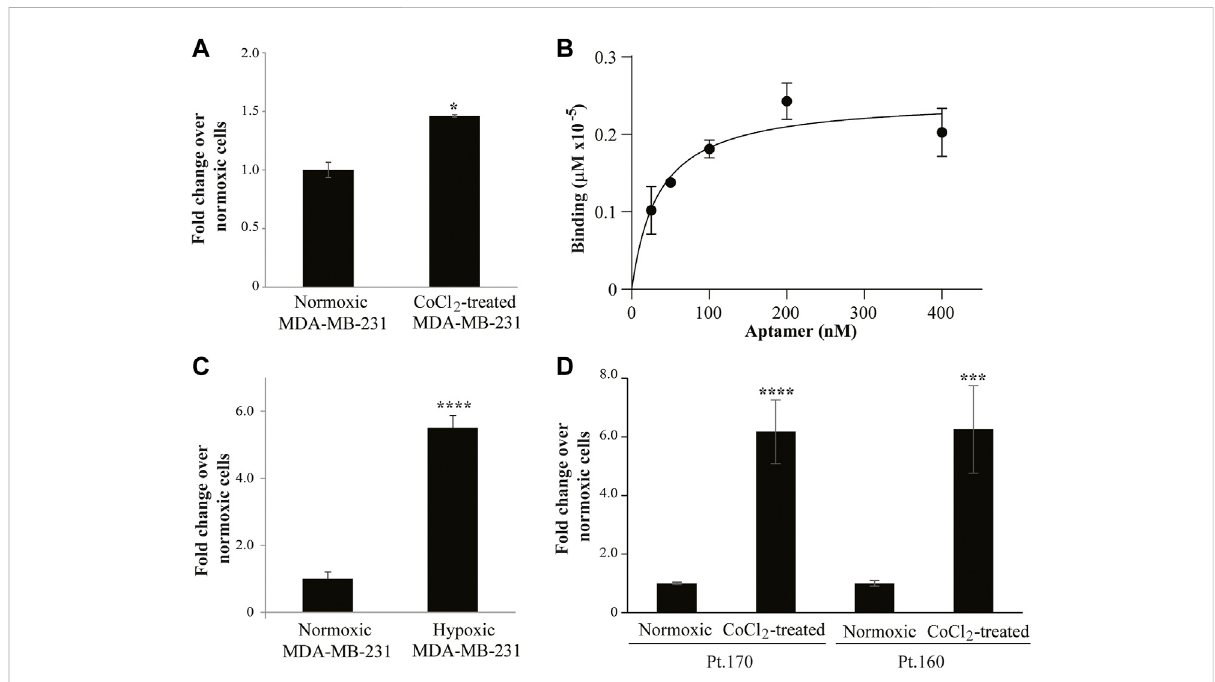
FIGURE 5 MA 39/76 aptamer binding ability. (A) MA 39/76 (100 nM) was incubated on CoCl 2 -induced MDA-MB-231 hypoxic cells or normoxic MDA-MB- 231cellsfor30 minat37 ° C.BindingvaluesweremeasuredbyqRT-PCR.Theerrorbarsshowthemean±standarddeviationvaluesonduplicates( n = 2) and statistics by Student ’ s t-test were performed, * p < 0.05. (B) Dose-dependent binding of MA 39/76 on CoCl 2 -induced MDA-MB-231 hypoxic cells. Error barsshow themean± standarddeviation. (C) MA 39/76 100 nM wasincubatedwith hypoxic chamber-mediatedMDA-MB-231cells or normoxic MDA-MB-231 for 15 min at 37 ° C. Binding values were measured by qRT-PCR. (D) Binding of 100 nM MA 39/76 on normoxic or CoCl 2 - inducedprimaryBCcells(Pt.170andPt.160).In (C,D) Mean±standarddeviationvaluesonreplicates( n =4)arereported;statisticsbyStudent ’ st-test, ***, p < 0.001**** p <